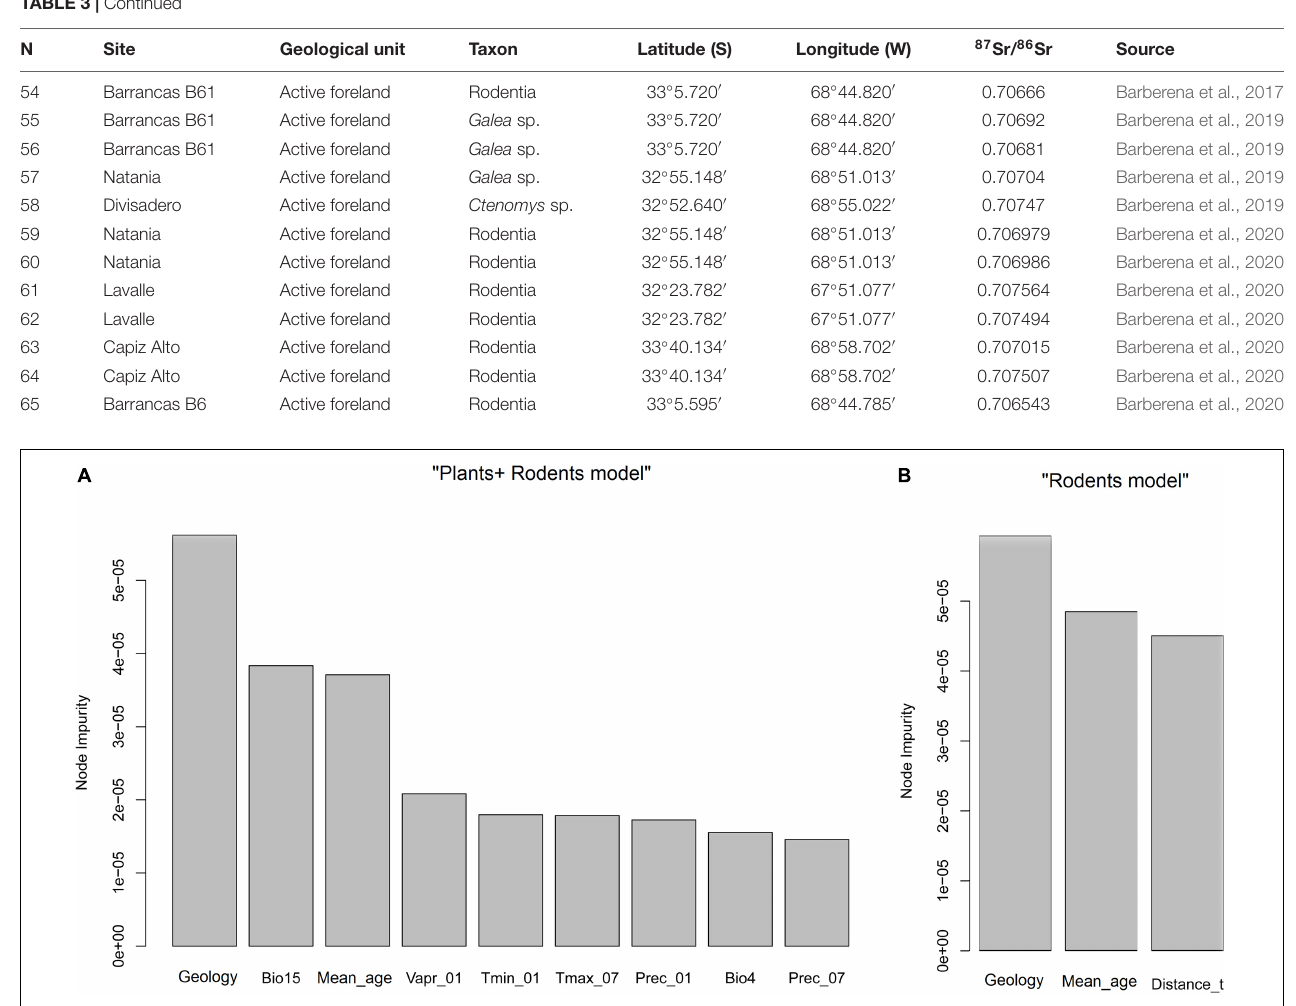
FIGURE 4 | Predictive power of the variables utilized in the Random Forest model: (A) “Plants + Rodents” model. (B) “Rodents” model.